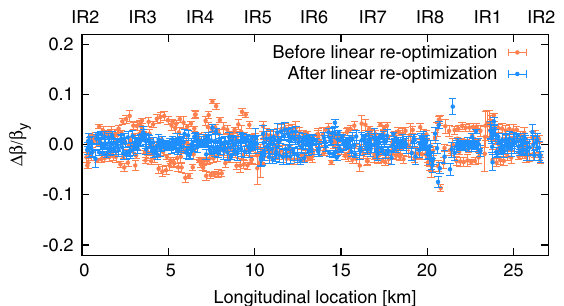
FIG. 27. Vertical β -beat of LHC Beam 1 before and after reoptimization of linear optics corrections at the operational configuration of the crossing